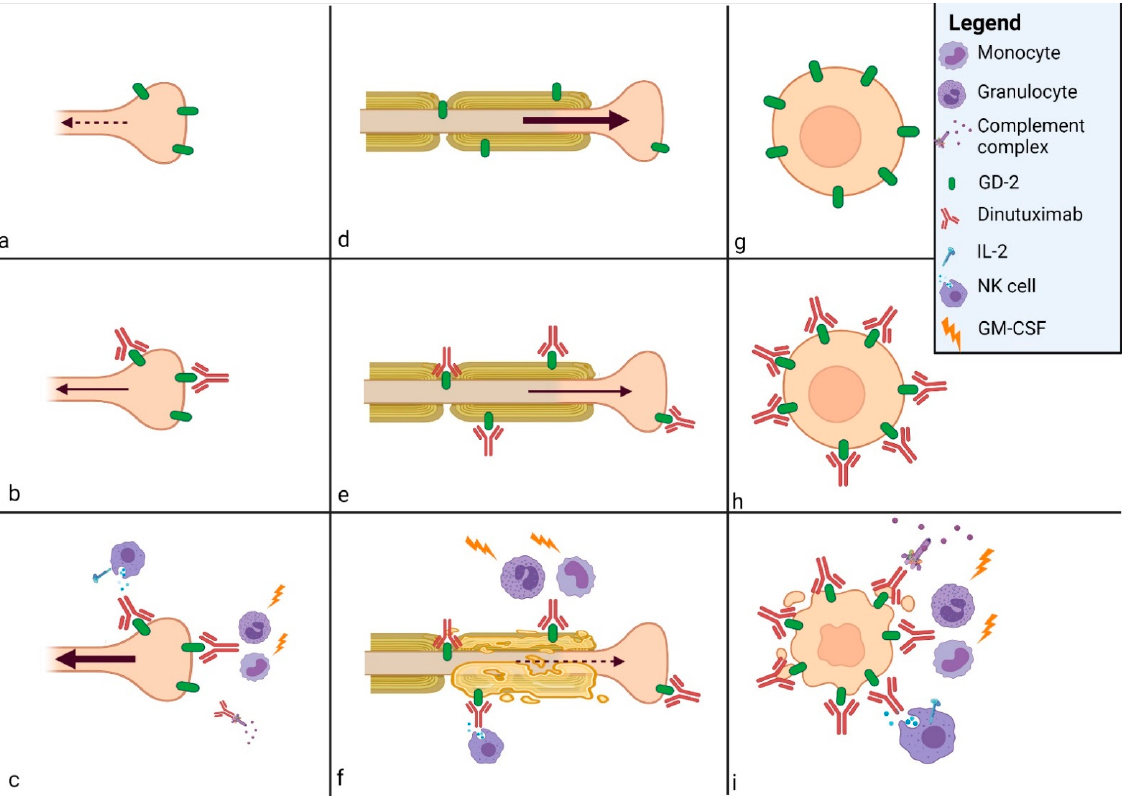
Figure 2. Mechanisms of action of dinutuximab beta. GD2 is expressed on ( a ) nociceptive fiber, ( d ) motor and sensory fibers, and ( g ) neuroblastoma cell membrane. The complex antigen–anti-GD2-antibody is formed on the surface of ( b ) nociceptive fiber, ( e ) motor and sensory fibers, and ( h ) neuroblastoma cell membrane. The complex antigen GD2-antibody activates the antibody-dependent cellular cytotoxicity and the complement-dependent cyto-toxicity, which cause ( c ) neuropathic pain on nociceptive fiber, ( f ) peripheral neuropathy on motor and sensory fibers, and ( i ) apoptosis of neuroblastoma cell. IL-2 acts on Natural Killer (NK) cells and granulocyte-macrophage colony-stimulating factor (GM-CSF) on monocytes and granulocytes to enhance the immunological response.